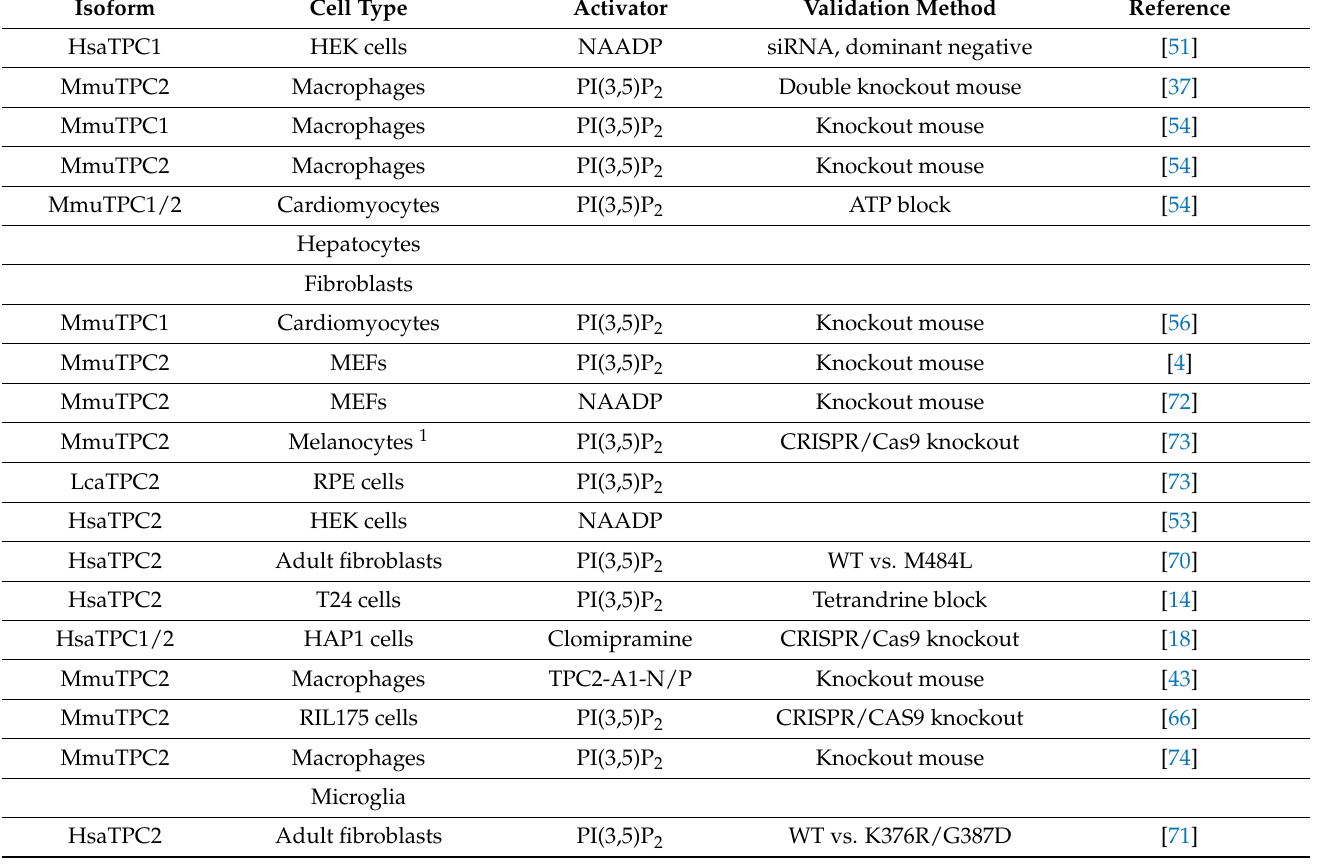
Table 1. Endogenous TPC channel activity. 1 Melan-a cell line derived from Oa1 − / − mice. Hsa, Homo sapiens ; Mmu, Mus musculus ; Lca, Lithobates catesbeianus